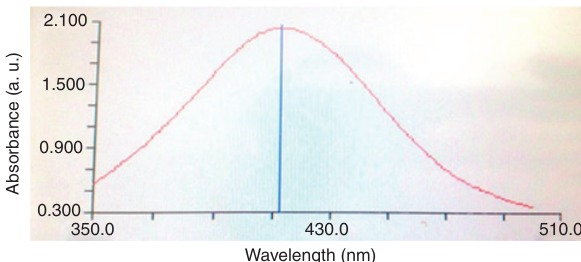
Figure 2: Surface plasmon resonance spectrum of the synthesized silver nanoparticles (AgNPs) at center point synthesis conditions.